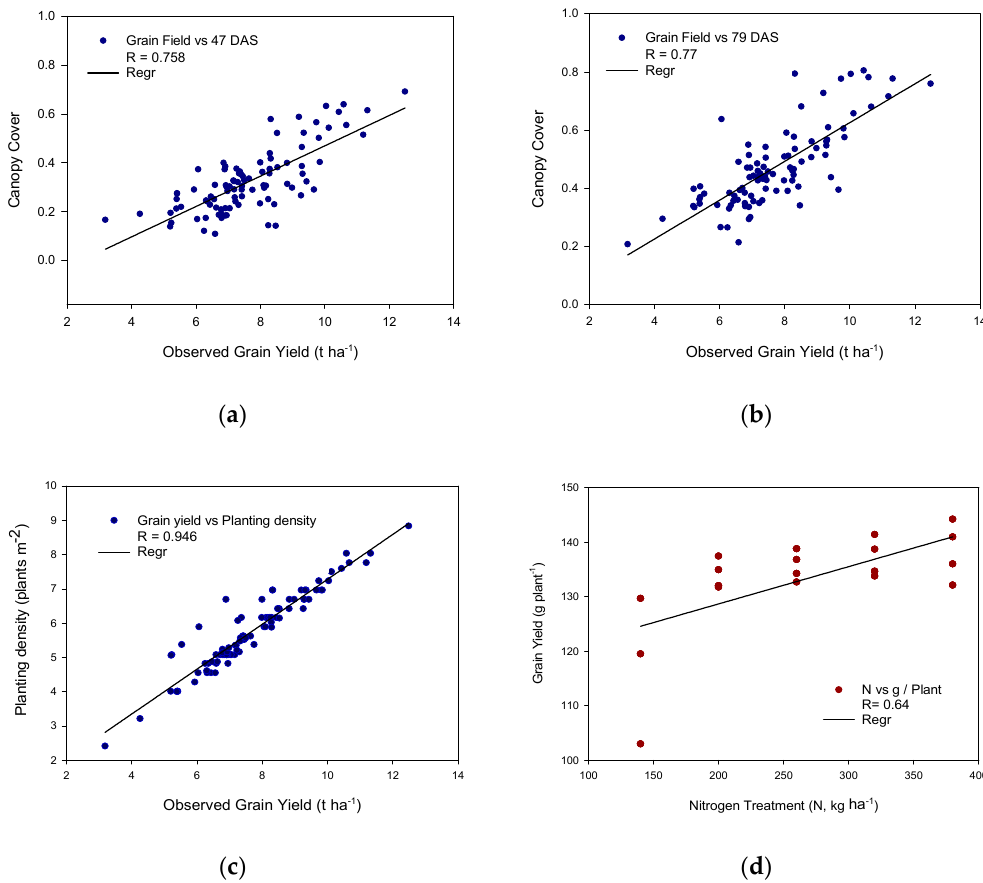
Figure 4. ( a ) Correlation between the canopy cover at 47 days after sowing (DAS) and yield; ( b ) correlation between the canopy cover at 79 DAS and yield; ( c ) correlation between plant density and yield; ( d ) correlation between the applied nitrogen dose and grain weight per plant.